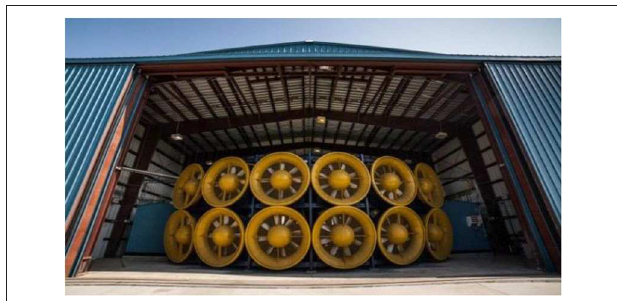
FIGURE 1 | Intake of 12-fan Wall of Wind system.